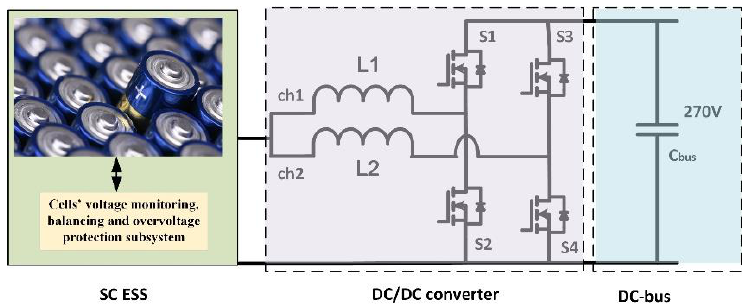
Figure 1. Supercapacitor energy storage system block diagram.